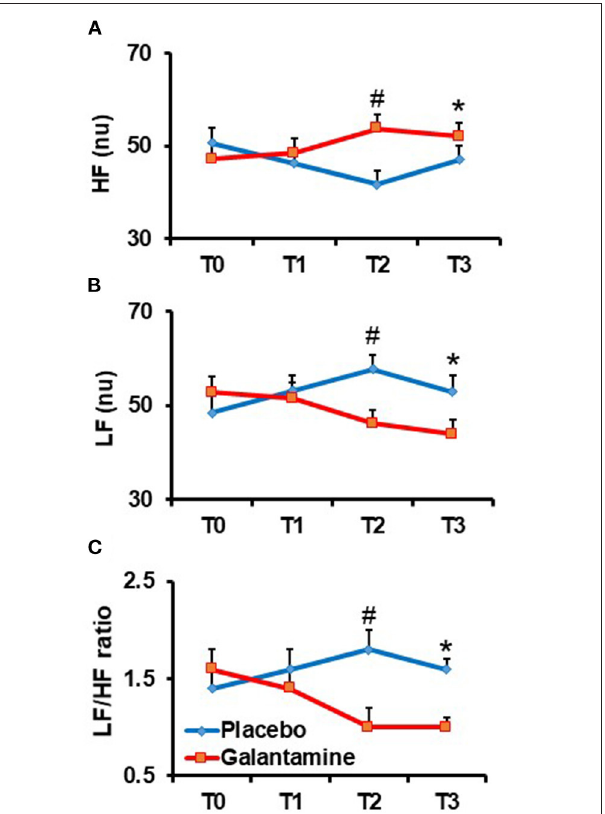
FIGURE 2 | Time course of galantamine effect on heart rate variability (HRV) parameters in the frequency domain. Analysis of galantamine effects as compared to placebo was performed at randomization (T0), and after 4 (T1), 8 (T2), and 12 weeks (T3) of follow up. (A) Effect of galantamine on the high frequency (HF) component of HRV: # P = 0.007 (T2 vs. T0); * P = 0.04 (T3 vs. T0). (B) Effect of galantamine on the low frequency (LF) component of HRV: # P = 0.009 (T2 vs. T0); * P = 0.005 (T3 vs. T0) (C) Effect of galantamine on the LF/HF ratio: # P = 0.001 (T2 vs. T0); P = 0.001 (T3 vs.